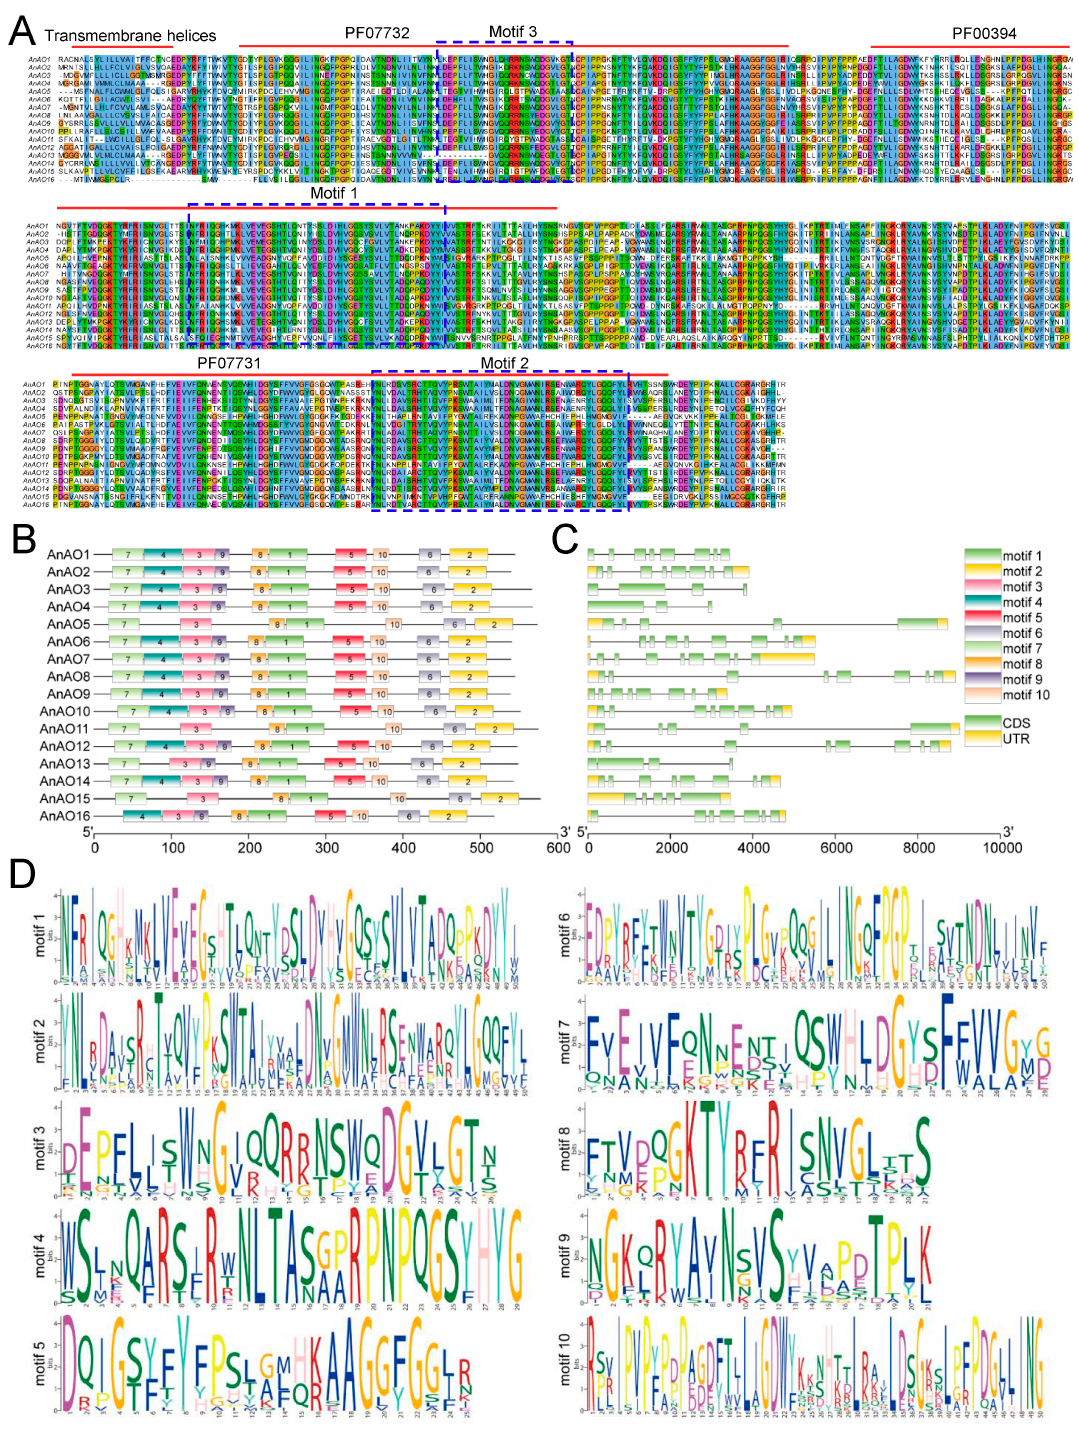
Figure 2. Structural analysis of the AnAOs of A. nanus . ( A ) Multiple sequence alignment analysis of AOs in A. nanus . ( B ) The conserved motifs of AO gene family in A. nanus . All motifs were predicted using the MEME database. The rectangular box represented the motif, and different colors represent different motifs. ( C ). The intro-exon structures of AO family genes. Black lines represent introns, yellow rectangles represent CDS, and green rectangles represent untranslated regions (UTRs). ( D ) Motif sequence logo graph. The relative size of the letters represents their frequency in the sequence. The height of each letter is proportional to the frequency of occurrence of the corresponding base at that